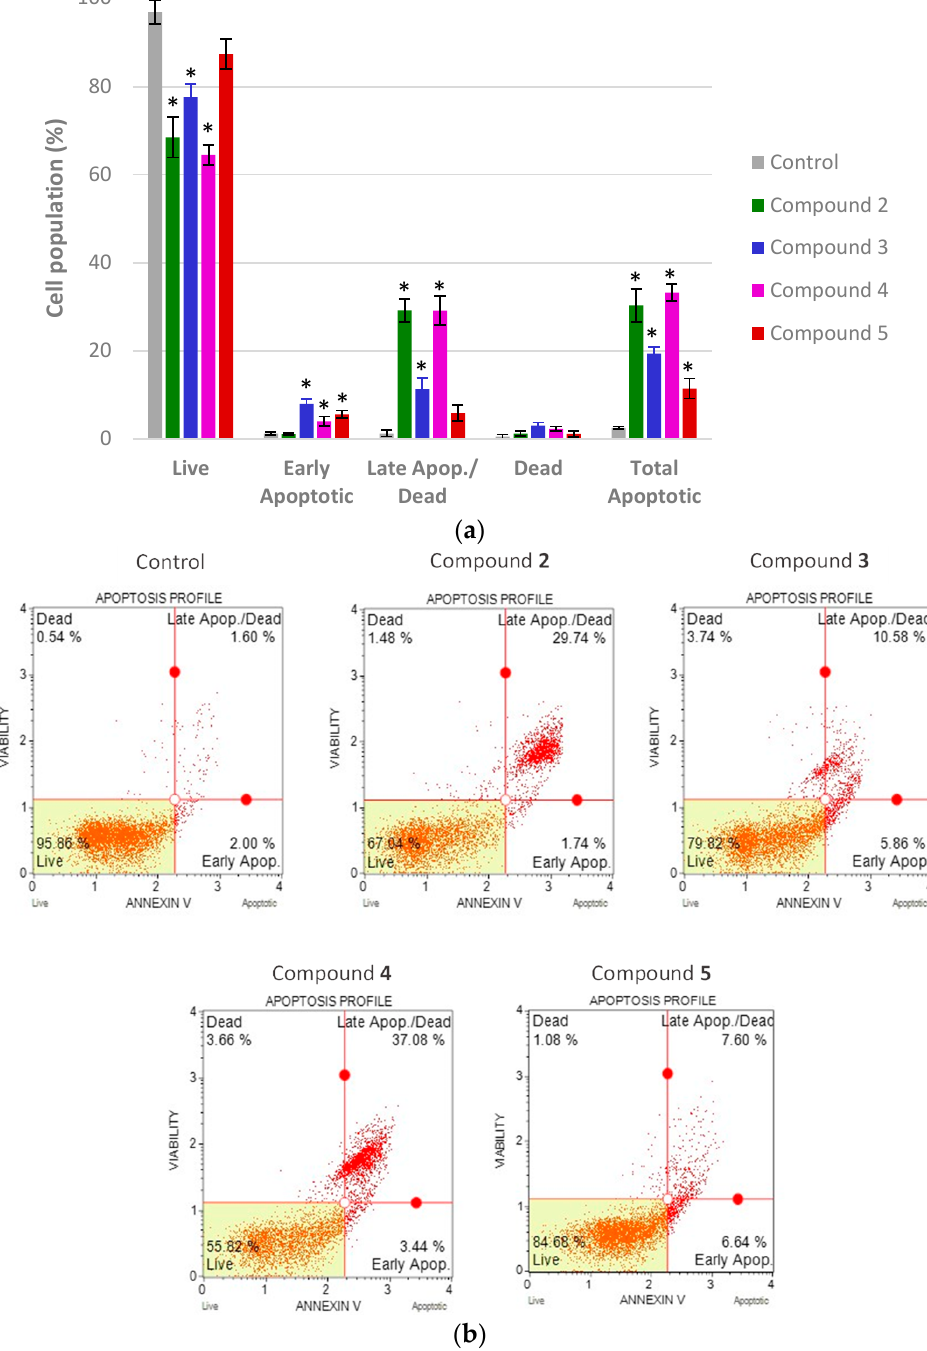
Figure 15. Cell death analysis of HeLa cells treated with the highest tested concentration of Boc-( 2 , 4 ) and Ac-peptides ( 3 , 5 ) (500 μ M) for 72 h. Distribution of four distinct cell populations ( a ). Values were represented as the mean (n = 2) ± SD from two independent experiments. * significant difference of treated cells versus control cells was considered at a p value < 0.05. Representative histograms for control and treated cells were given from the Muse Annexin V & Dead Cell assay ( b ).